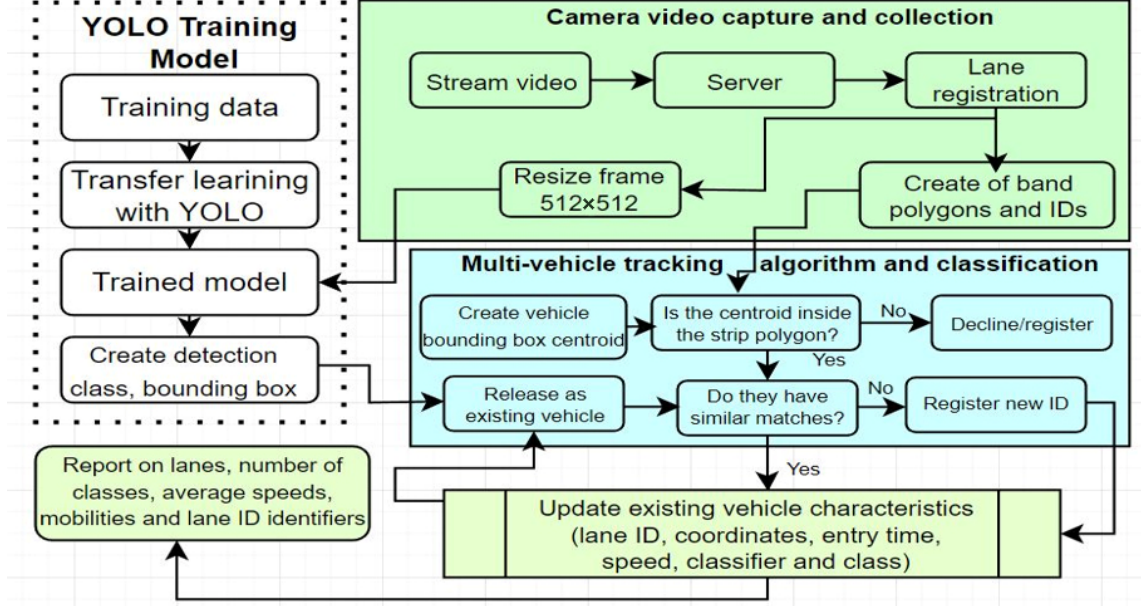
Figure 4. Diagram of vehicle analysis and classification model.